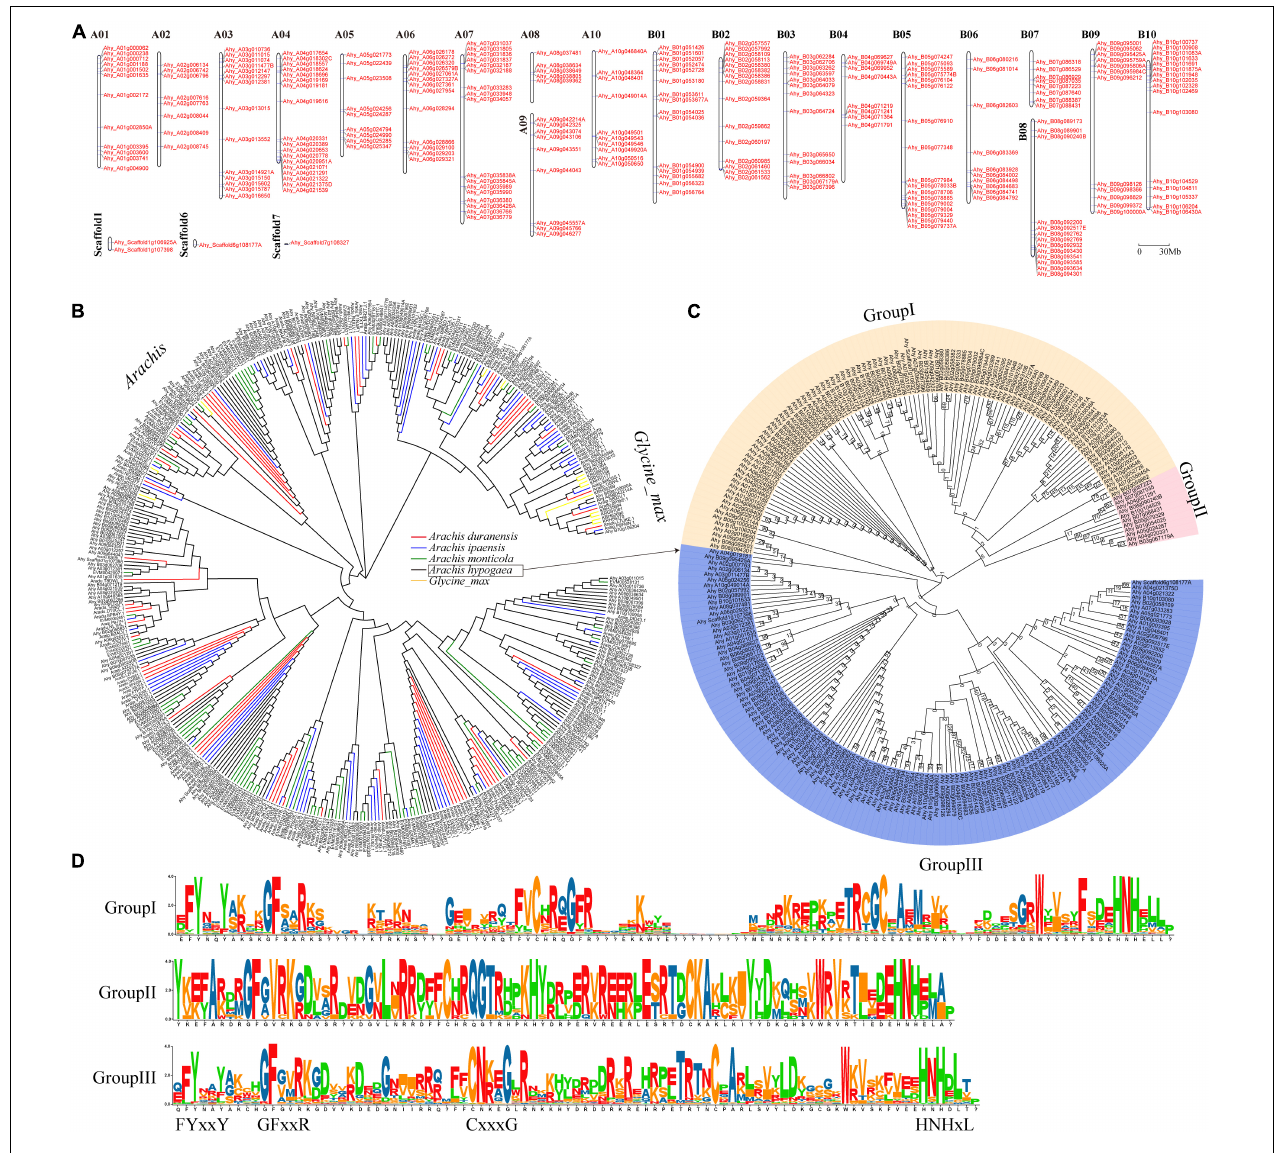
FIGURE 1 | Genome-wide distribution and phylogenetic tree of AhFAR1 domains. (A) Distribution of the 246 AhFAR1 genes on peanut 20 chromosomes and 3 scaffolds. (B) Phylogenetic tree of FAR1 domains of different Arachis and G. max . (C) Phylogenetic tree of 246 AhFAR1 domains of A. hypogaea . The numbers at the nodes represent bootstrap percentage values computed by 1,000 replications. (D) Motif analysis of three subgroups of 246